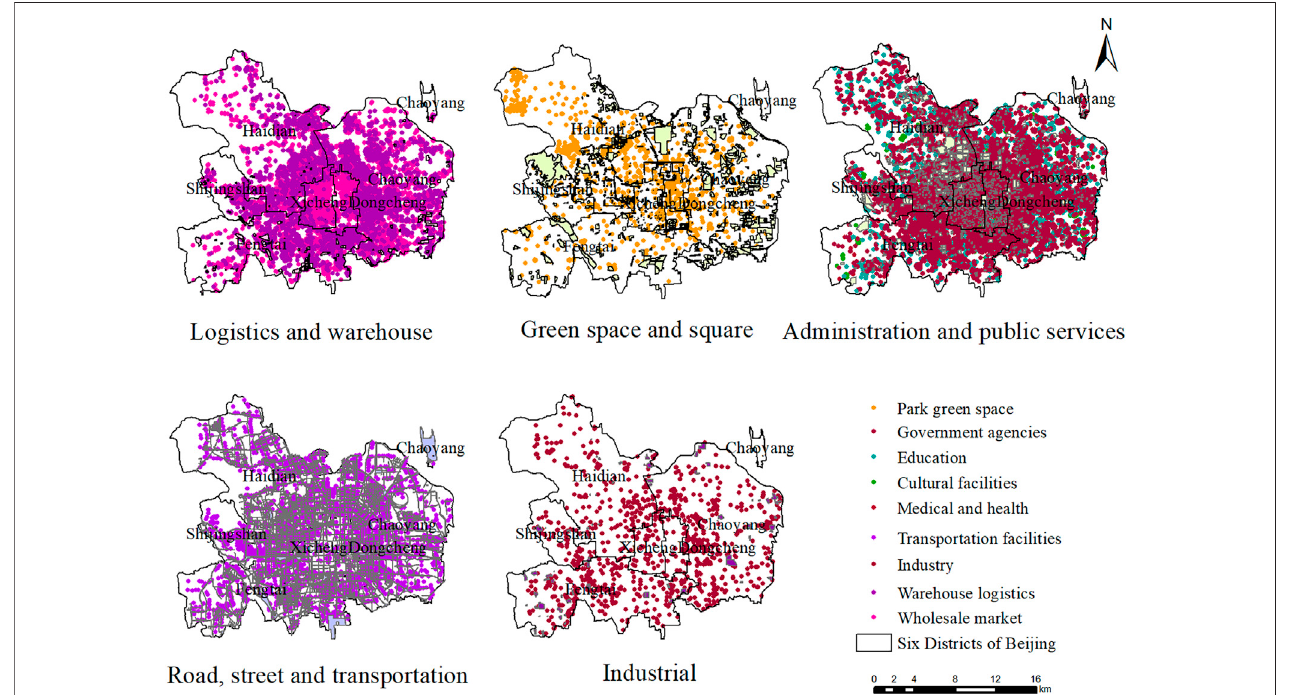
FIGURE 9 | Combination of various types of POI and land type interpretation maps in 2019.